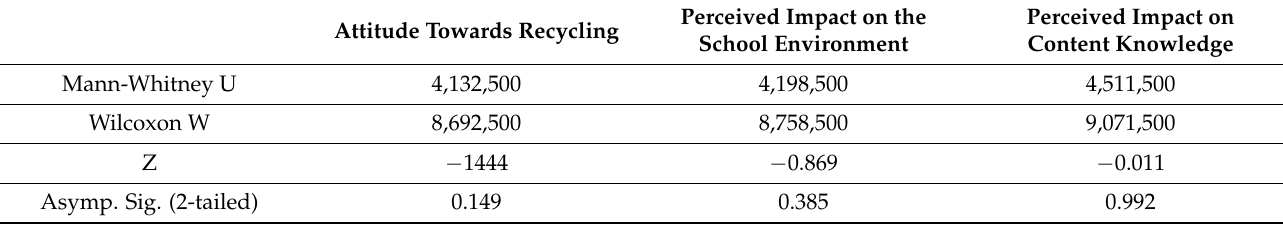
Table 6. A comparison of learner’s attitudes towards recycling, perceived impact on content knowledge, and perceived impact on the school environment in the experimental group were measured before and after participation in the school- based recycling project.